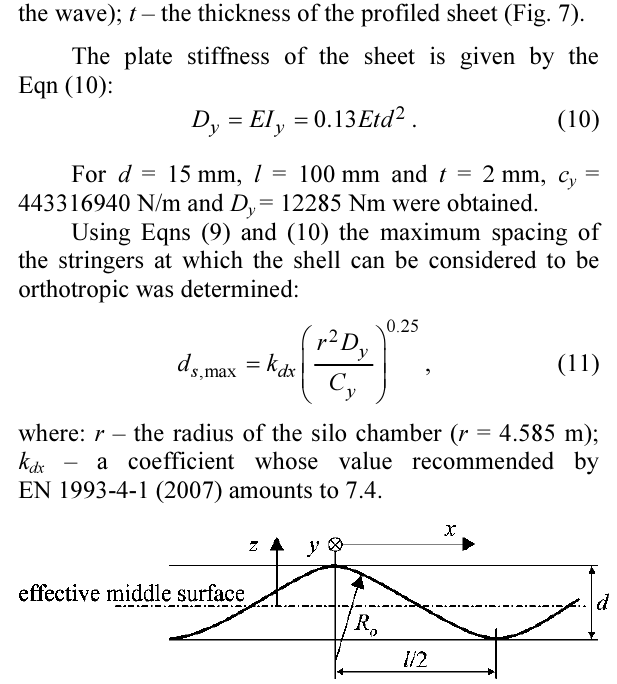
Fig. 7. Cross section of corrugation and geometric parameters of profiled